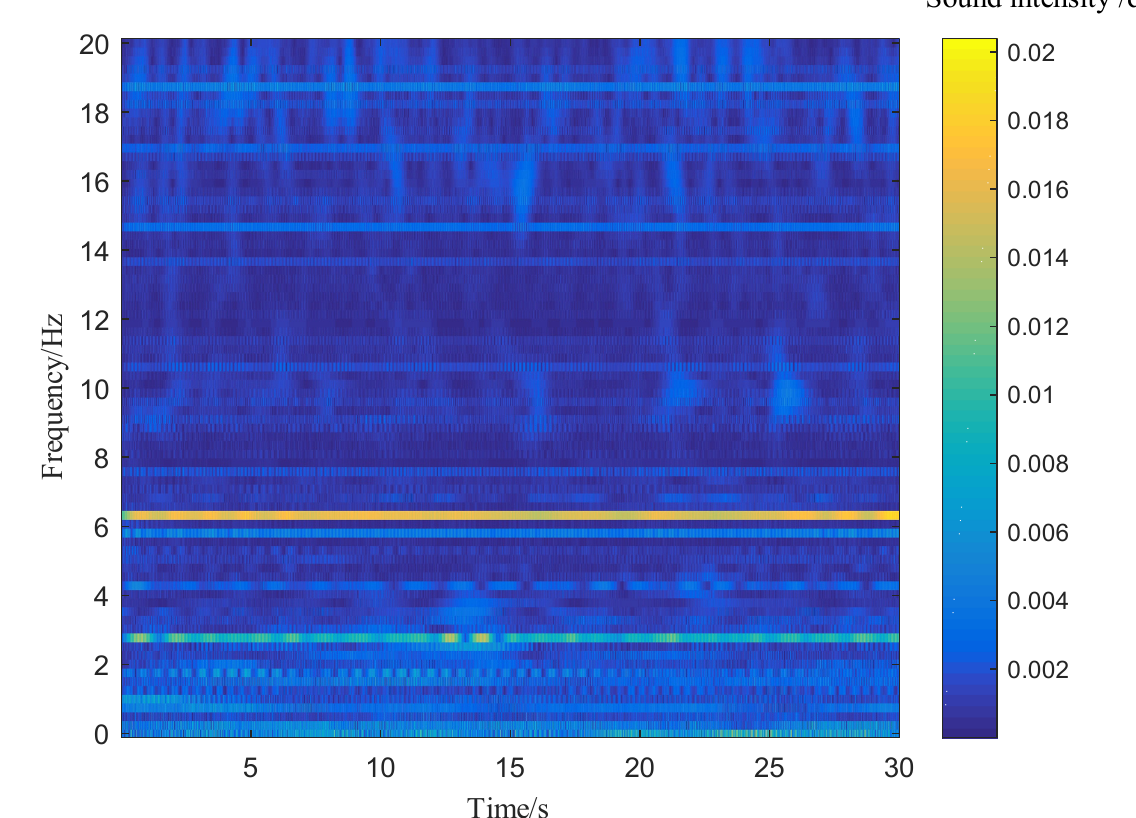
Figure 4. Time-frequency analysis of background noise.